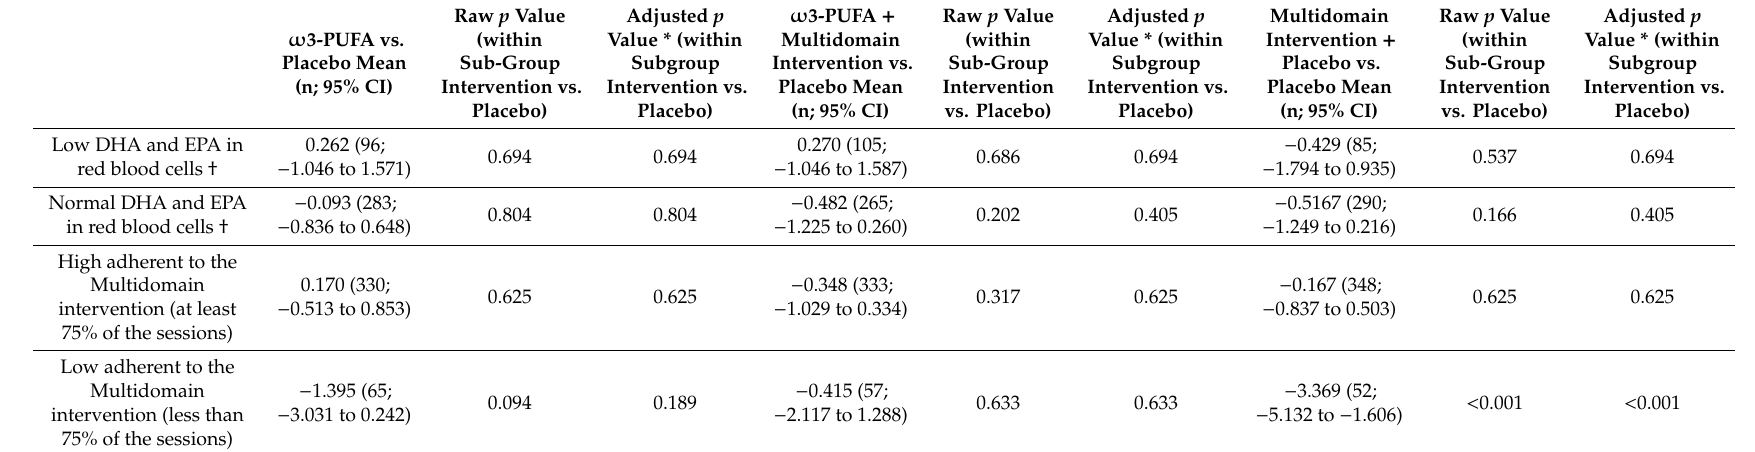
Table 5. Estimated 3-year mean di ff erence in change from baseline on repeated chair stand test in the three intervention groups compared with the control group (95%